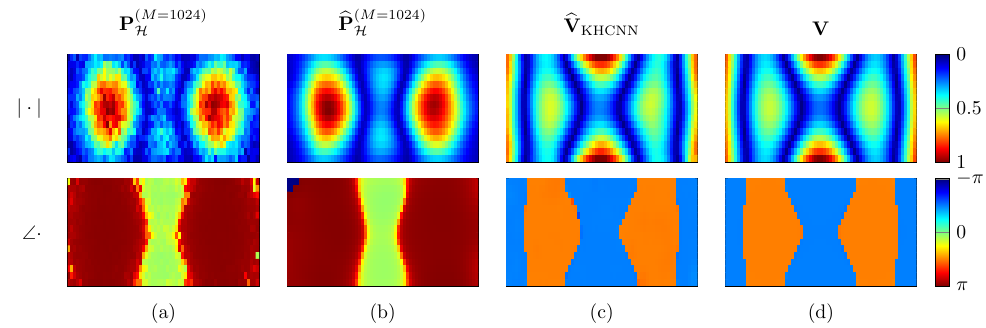
Figure 7. KHCNN reconstruction example for a rectangular plate with dimensions [ L x , L y , L z ] = [ 0.33,0.15,0.002 ] m vibrating at 548Hz. The first and the second row depict the magnitude and phase of the complex fields, respectively. Column ( a ) is the input pressure at the hologram in M = 1024 points. The reconstructed pressure from the KH model is shown in column ( b ). The velocity estimate and ground truth are depicted in column ( c , d ),